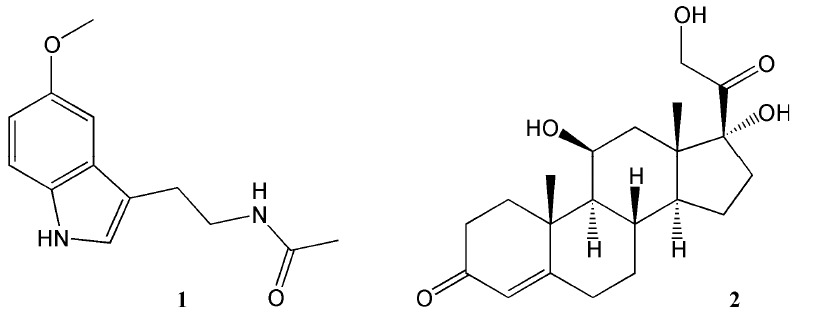
Figure 2. key hormones regulating circadian rhythms. 1 = melatonin, 2 = corticosterone . Figure 2. Key hormones regulating circadian rhythms. 1 = melatonin, 2 = corticosterone. Due to the impact of circadian oscillators on the physiology and behaviour of organ- isms, their dysregulations and disruptions are associated with the development of diverse pathologies. In mouse models, mutations or deletions in core circadian genes (e.g., BMAL1) cause increased levels of glucose and lipids, leading to premature ageing [29].